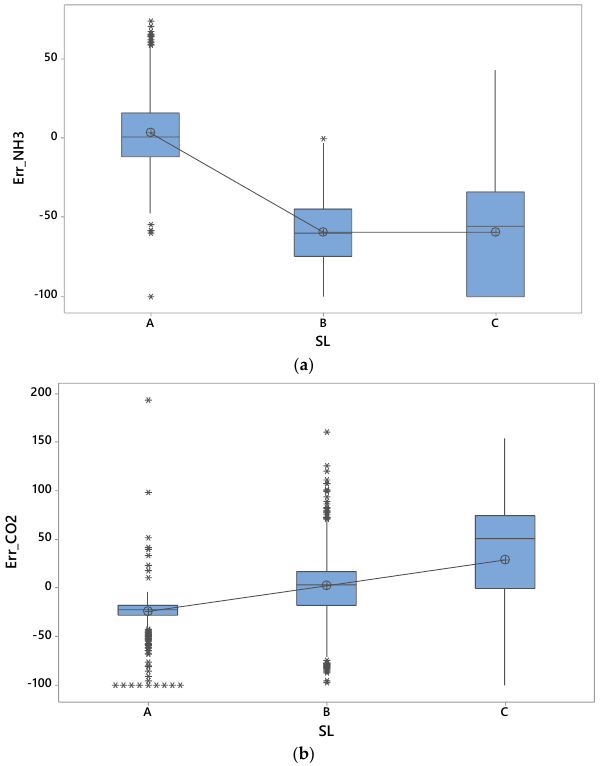
Figure 6. Boxplots of the error of gas concentrations for measurements carried out at SLA, SLB, and SLC by portable devices for both NH 3 ( a ) and CO 2 ( b ). The symbol * identify outliers.